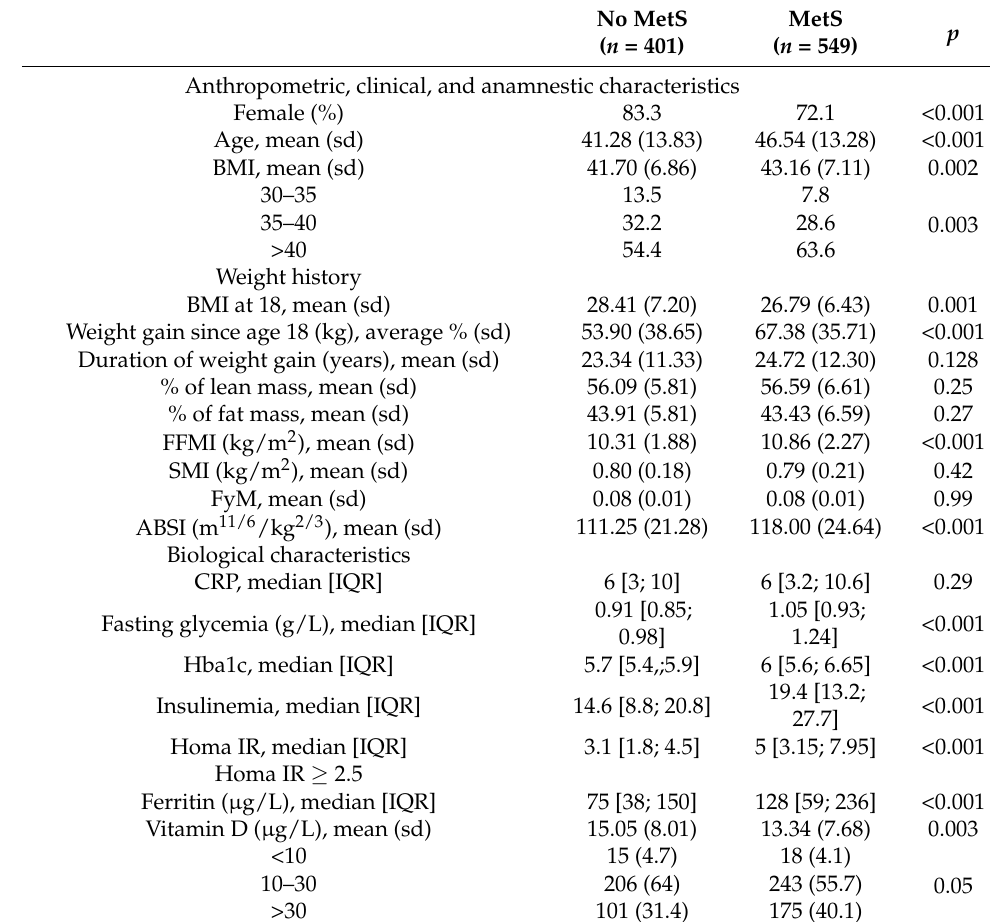
Table 2. Univariate analysis of factors associated with metabolic syndrome, using propensity score weighting.